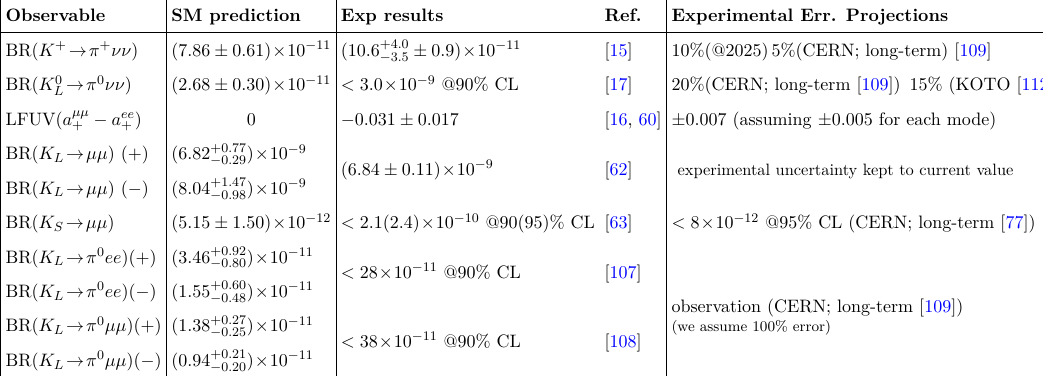
Figure 6 . BR( K L → π 0 ‘ ¯ ‘ ) as a function of δC ‘ between direct and indirect CP-violating